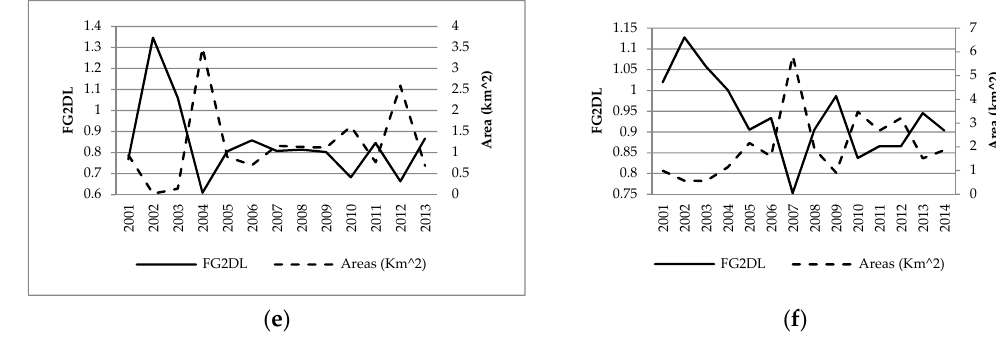
Figure 6. Temporal evolution of FG2DL (Fixed Grid 2D Lacunarity) and deforested areas: ( a ) Maramure ș County; ( b ) Bor ș a; ( c ) Poienile; ( d ) Repedea; ( e ) S ă pân ț a; ( f ) Vi ș eu de Sus.